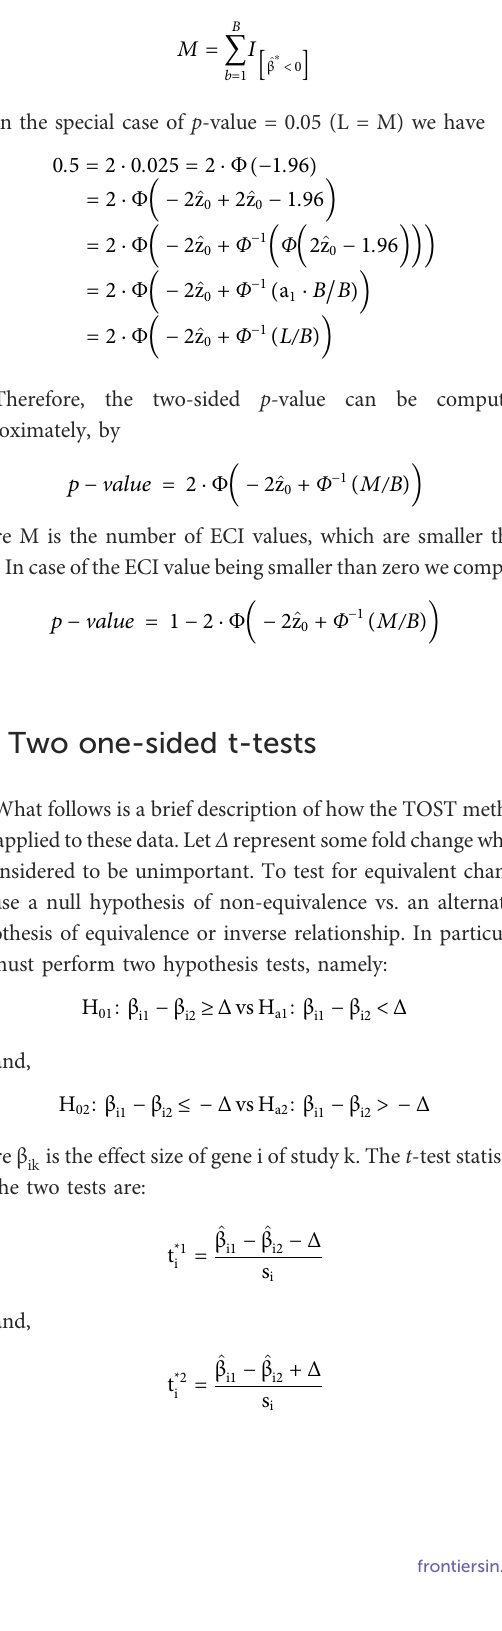
(cid:129) recalculate ECI values between studies for each gene We repeated this procedure 1,000